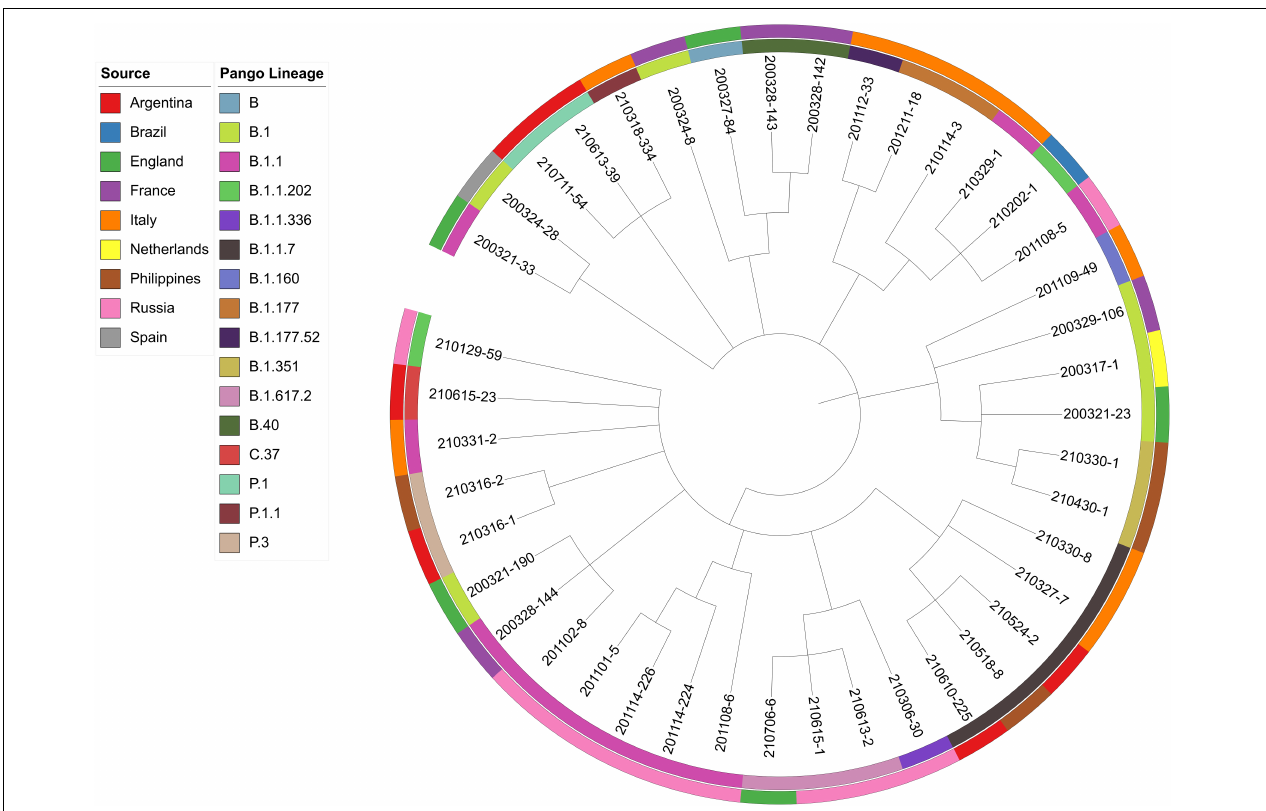
FIGURE 3 | Phylogenetic analysis of 42 samples imported from abroad in Nanjing. The sources and lineages are marked with different colors. The following data are shown (from outer to inner): sources, Pango lineages and